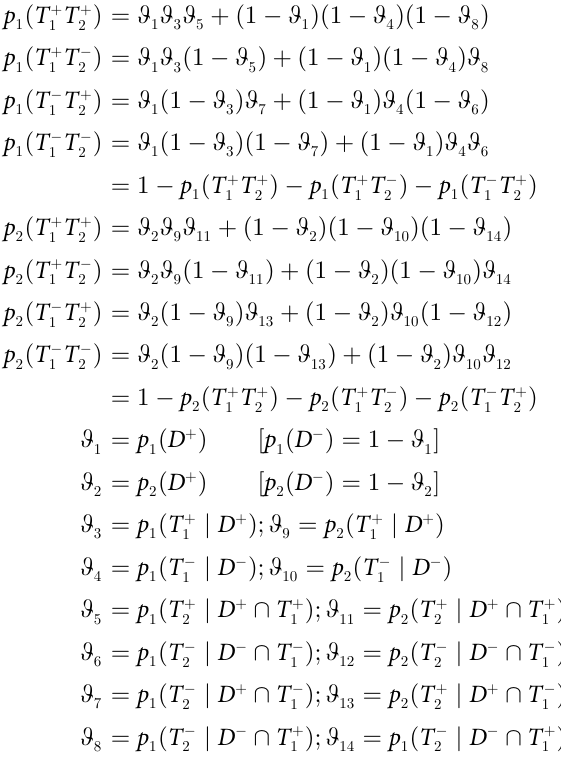
: number of test results with i = test (1 = IFAT, i